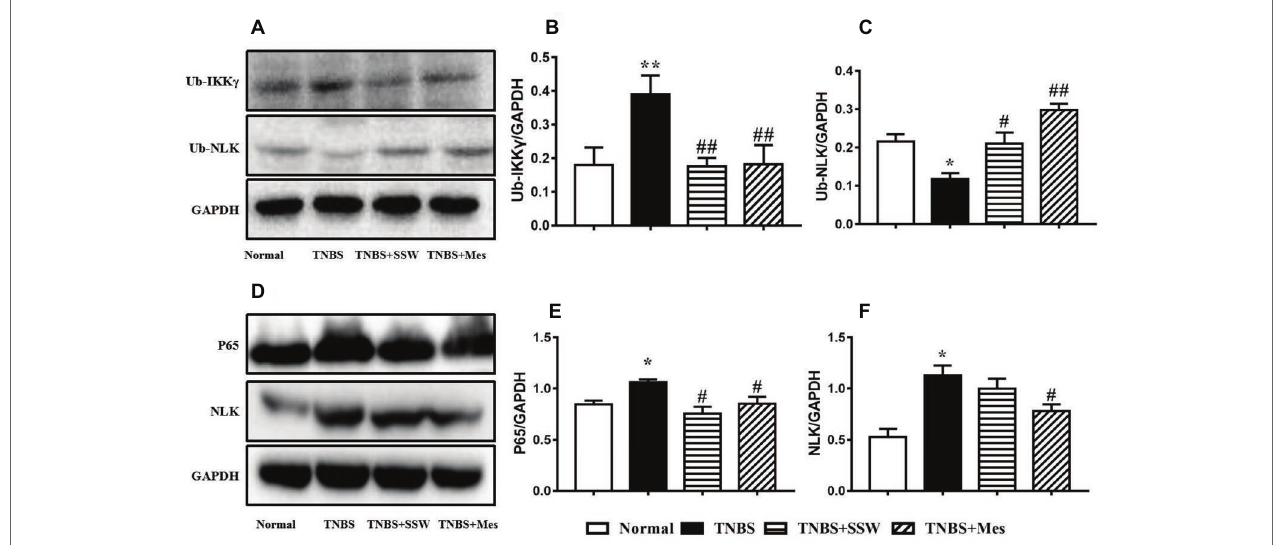
FIGURE 4 | Western blot analysis of ubiquitinated (Ub)-IKK γ (NEMO), Ub-NLK, NF- κ B P65, and NLK. (A) Western blotting of Ub-IKK γ and Ub-NLK. (B) Quantitative analysis of Ub-IKK